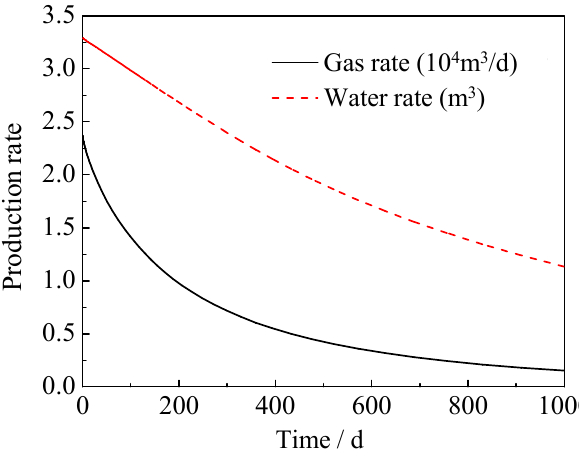
Figure 2. Comparison of results from numerical simulation and the proposed model .